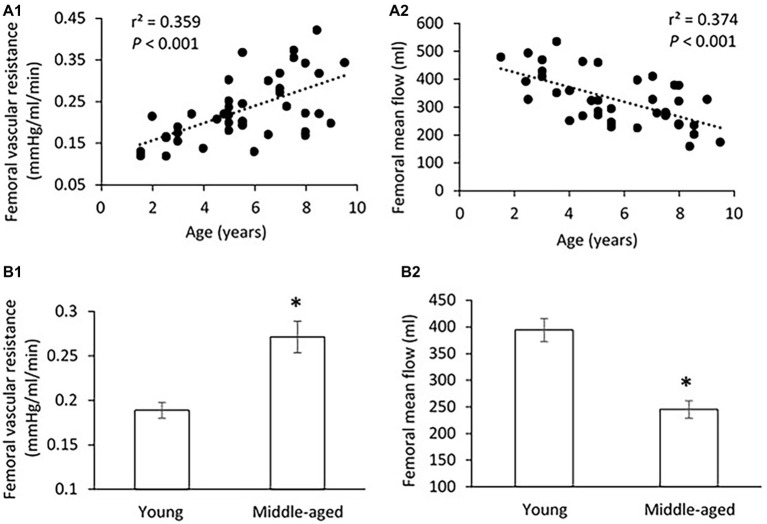
(A) Correlations of femoral vascular resistance (A1) and mean flow (A2) with age. The linear regression analysis was conducted, and data are expressed as correlation coefficients and significance levels (r2; p). (B) Comparison of femoral vascular resistance (B1) and mean flow (B2) between young and middle-aged pigs. Data corresponds to means ± SEM. p < 0.05, when compared to young group.